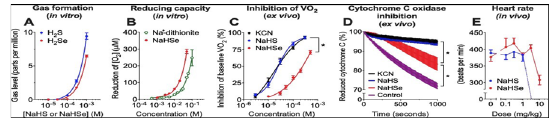
Fig. 1 (abstract 000883). Gas formation, redox activity and pharmacology of NaHSe. *p<0.05; overall 2-way RM ANOVA.